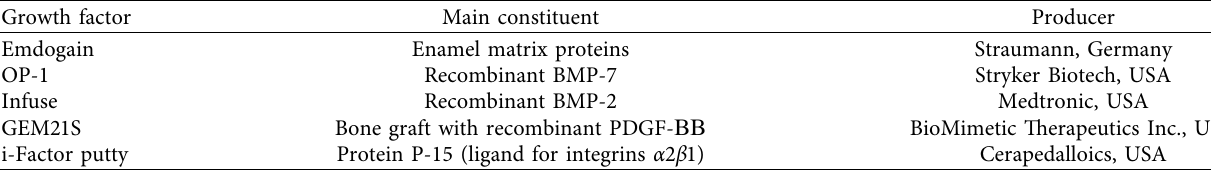
Table 2: Various growth factors used with bone grafts.